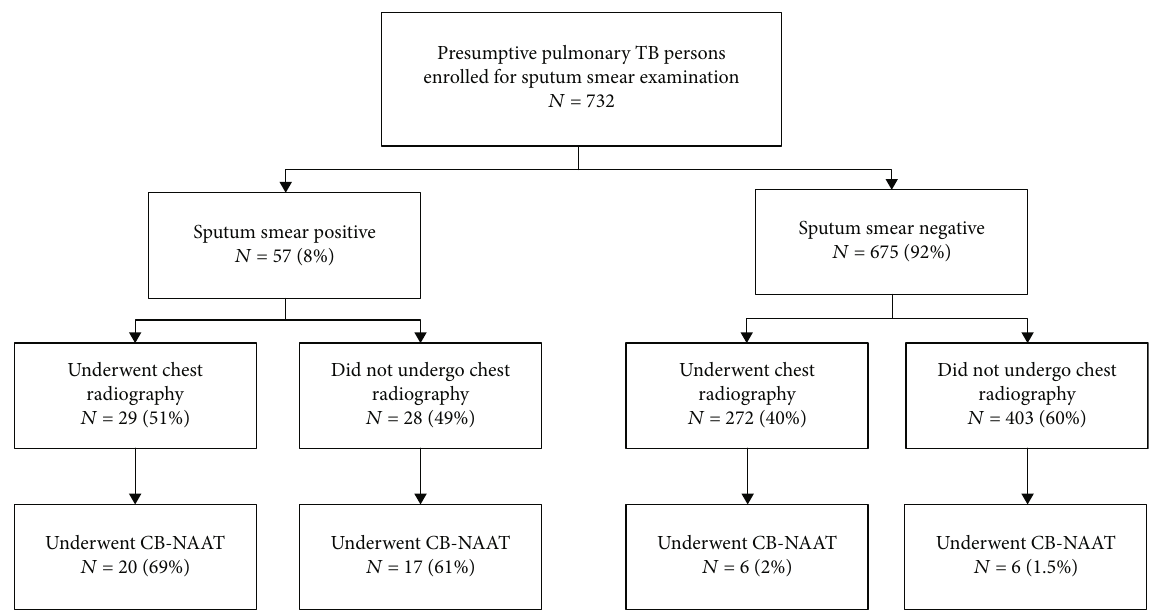
Figure 2: Status of chest radiography (CXR) and CB-NAAT tests in presumptive pulmonary TB patients undergoing sputum smear examination at seven selected designated microscopy centres in Chikkaballapur district, February to March,